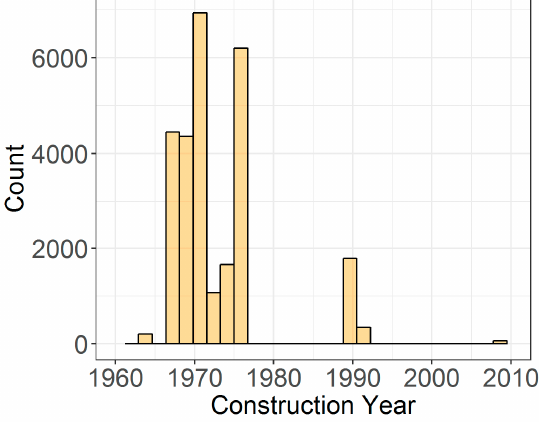
Figure 13. Survival time calculation (considering slab repair work).